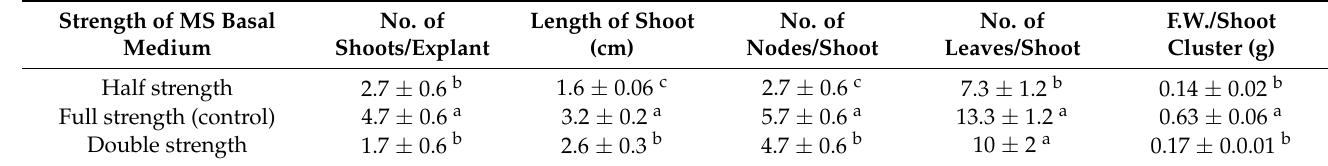
Table 4. Effect of different strengths of semisolid MS medium containing 2 mg/L BAP and 0.1 mg/L NAA on shoot multiplication and growth of paulownia for one month. Values are means ± SD.